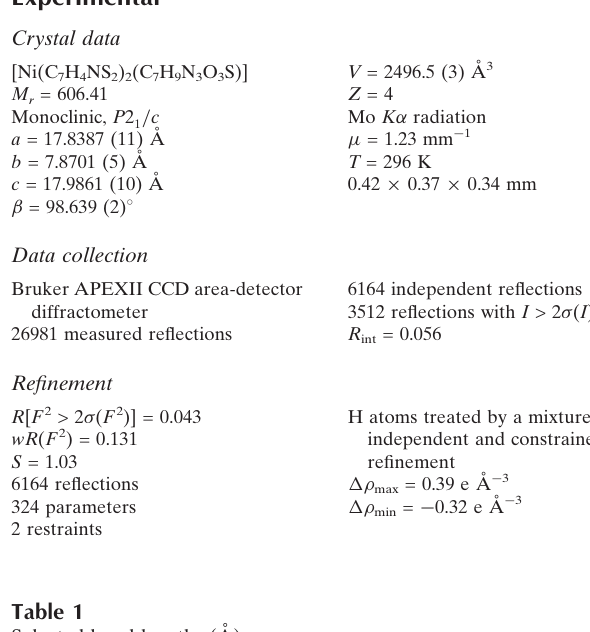
Selected bond lengths (A˚ ).